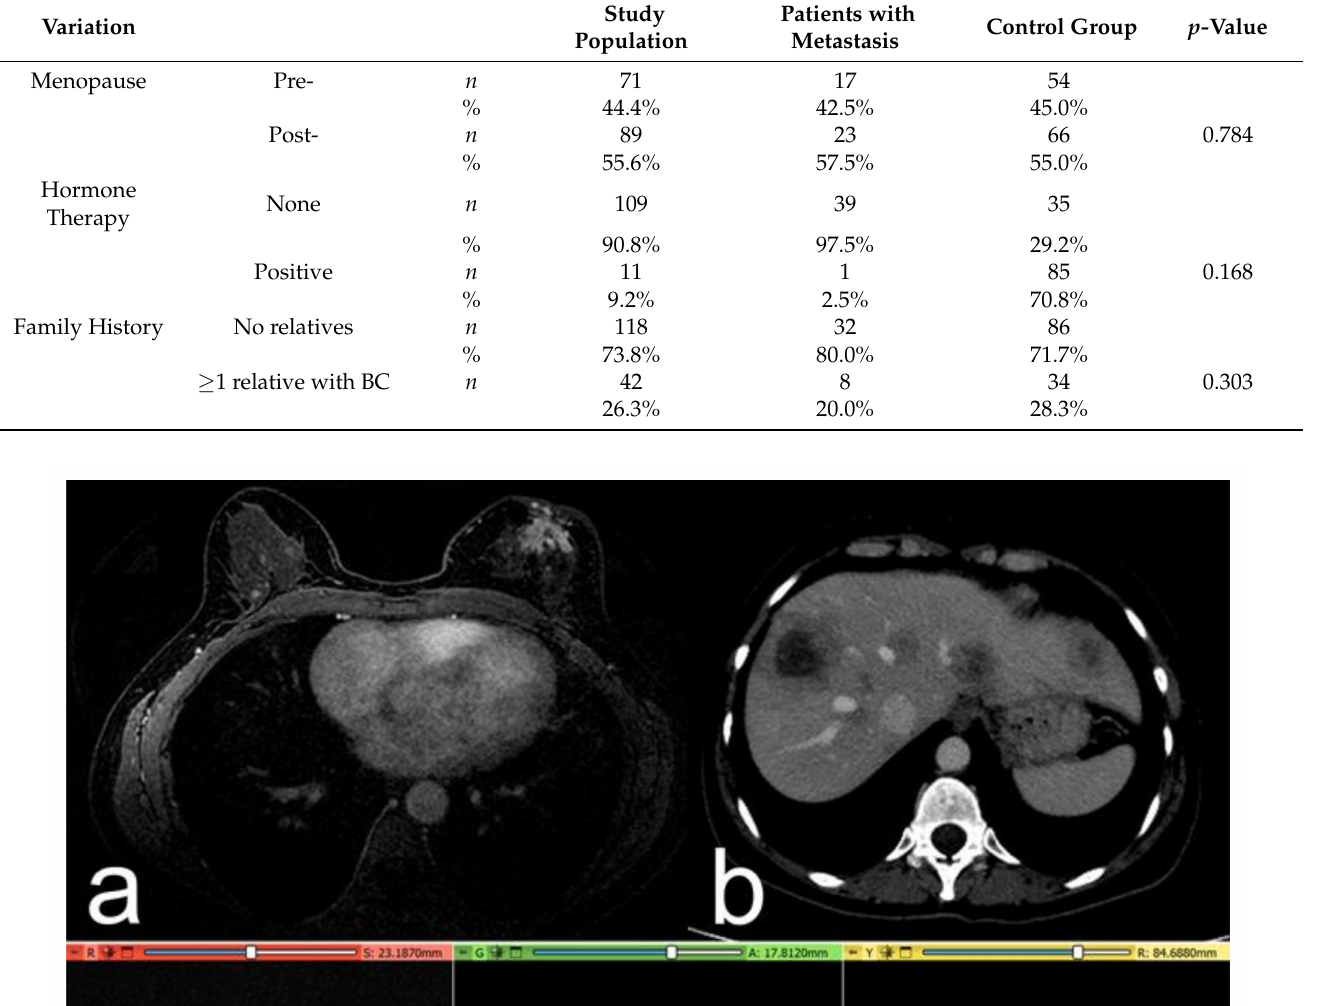
Table 3. Description of the extracted clinical characteristics.